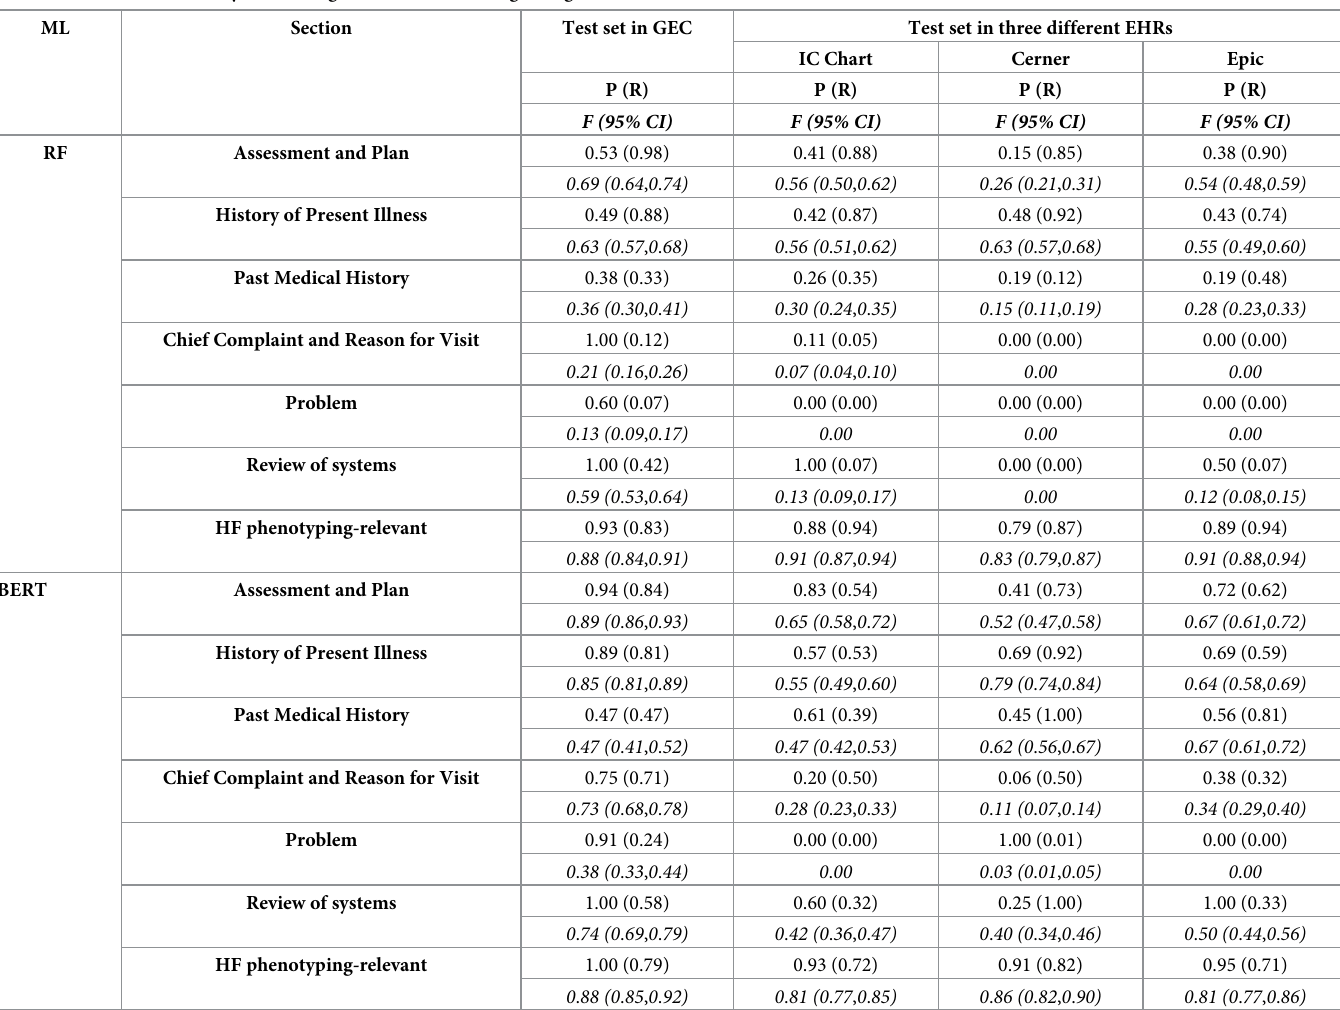
Table 3. Evaluation of binary embedding-based ML models regarding the section.